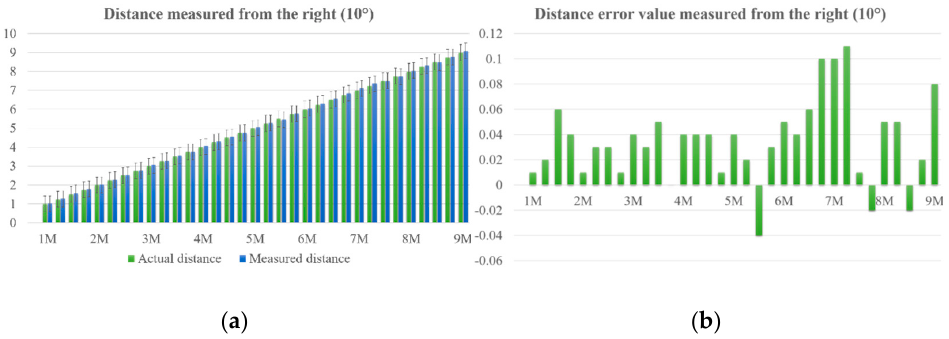
Figure 9. ( a ) Distance measured from the right (10°), ( b ) distance error value measured from the right (10°).